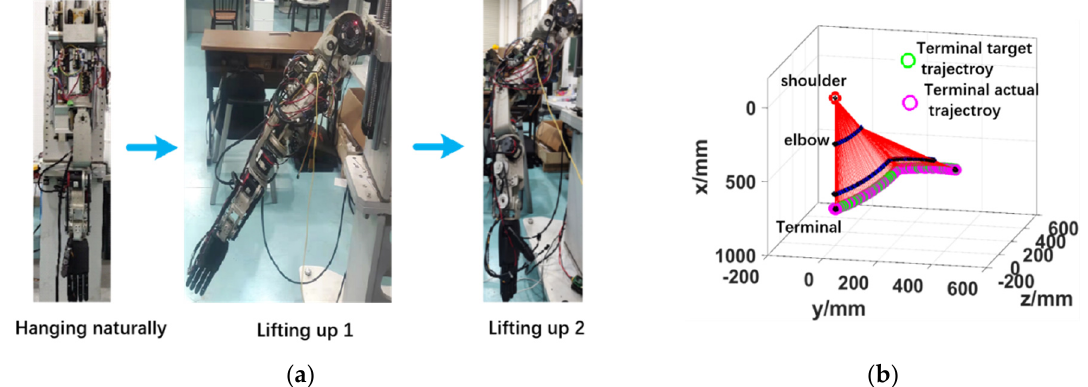
Figure 8. Simulation and physical schematic of humanoid manipulator movement. ( a ): Physical schematic ( b ): The simulation movement.